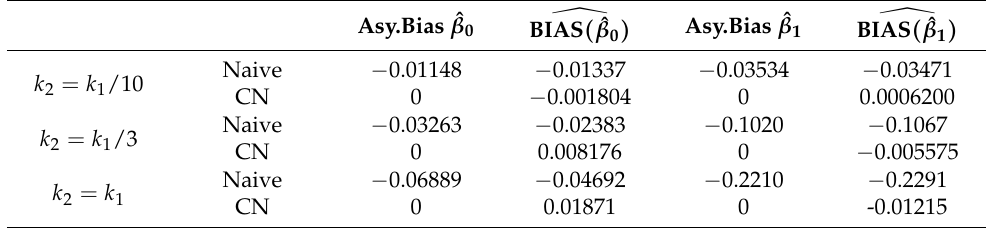
Table 7. Estimated bias and asymptotic bias in football data.